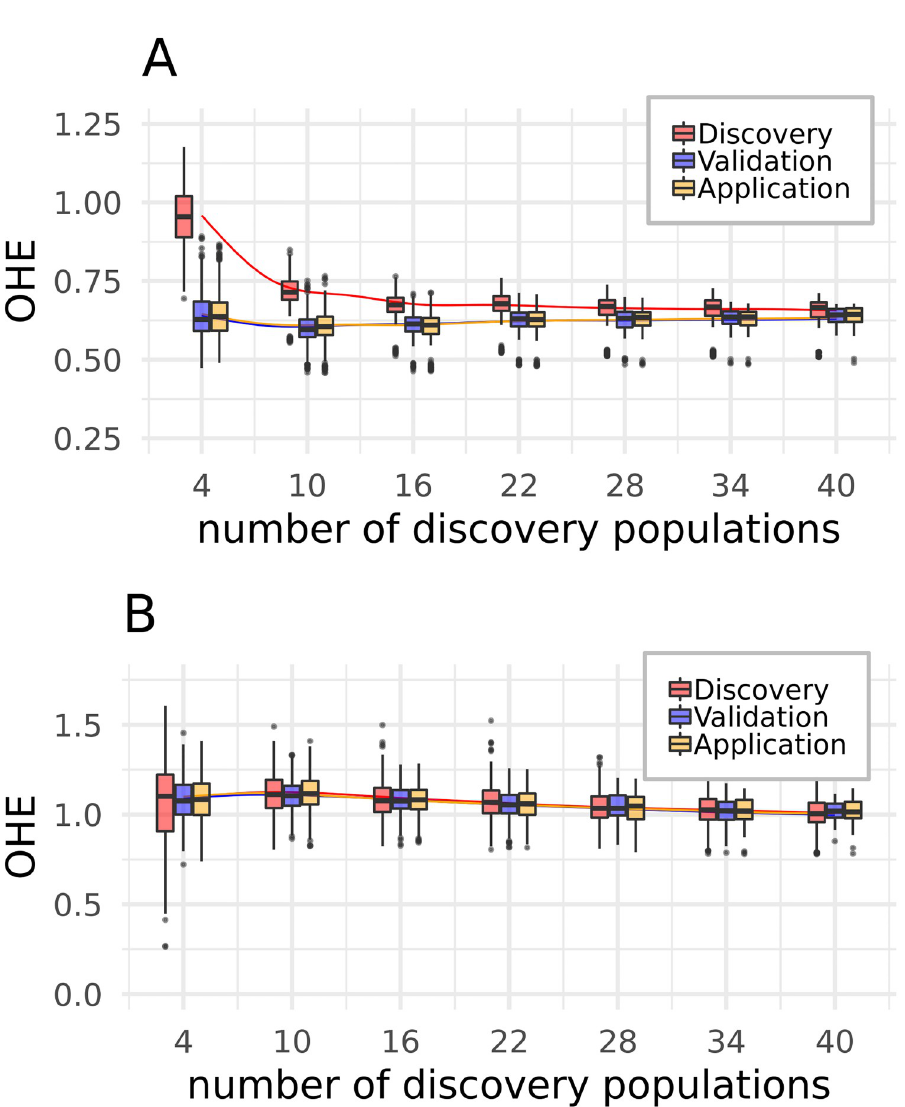
Fig 6. Relation of the OHE as a function of the number of discovery populations. A —discovery, B —equal spacing. While the number of discovery populations was varied from 4 to 40 by increments of one, the Boxplots are only shown for a subset of the number of discovery populations to avoid a crowded figure. The smoothing lines, which show the trend, are calculated from all observations. Plots for all five steps can be found in S9 Fig.